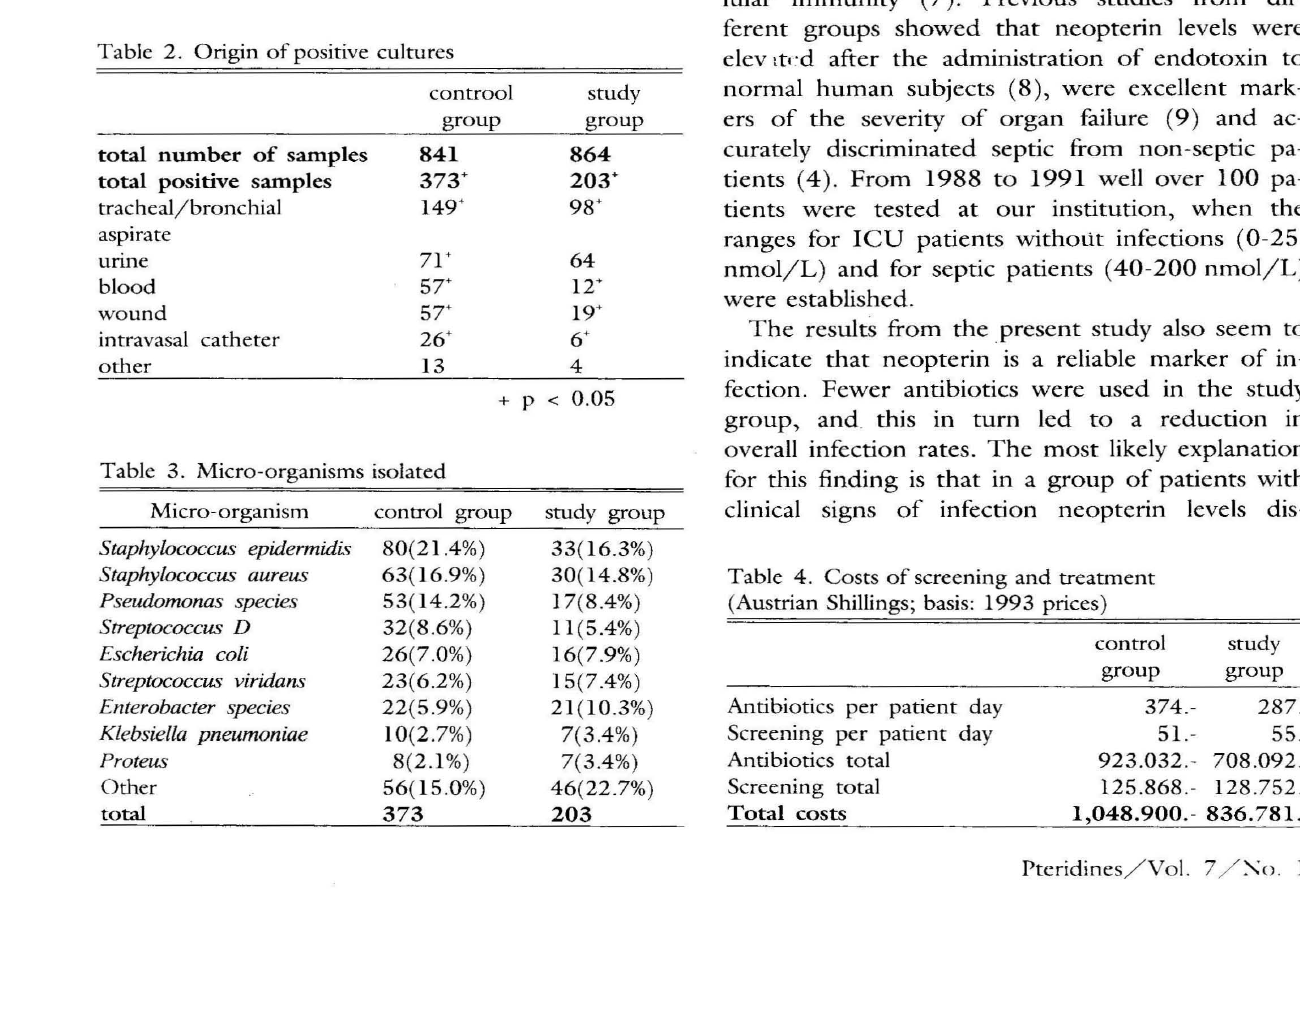
Table 2. Origin of positive cultures